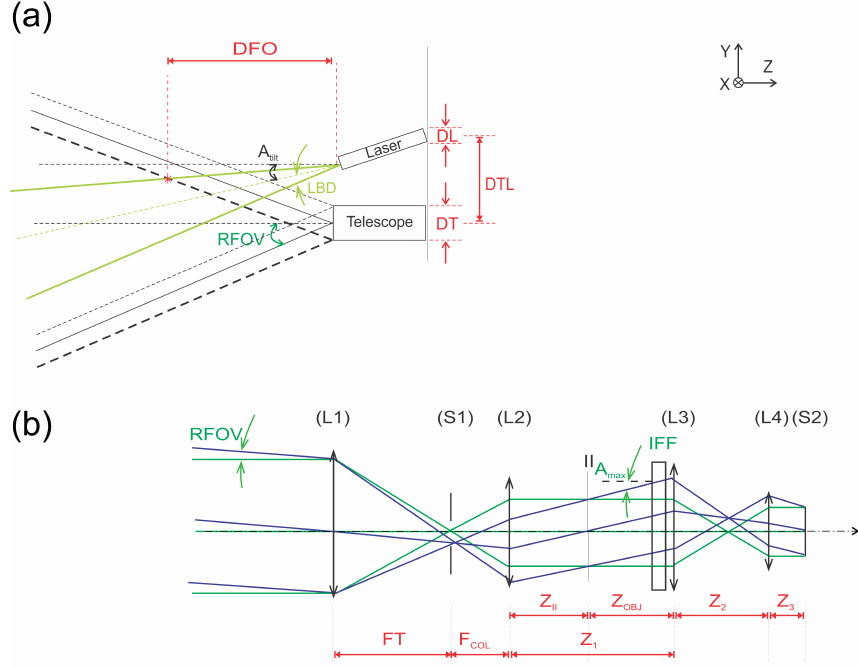
Figure 1. (a) The laser telescope geometry of a biaxial lidar system with a laser tilt A tilt and distance of full overlap DFO. RFOV and LBD are the receiver’s field of view and laser beam divergence respectively (half angles). Due to the small angle approximation, the errors are negligible when defining the laser beam diameter (DL), as if the laser was not tilted, and the distance between the laser telescope central axes (DTL) at the back of the laser and telescope. (b) The optical setup of a lidar receiving unit with a telescope (L1), field of view diaphragm LBD (S1), collimating lens (L2), interference filter and objective lens (L3) and an eyepiece lens (L4). Rays collected from on-axis (green lines) and off-axis points (blue lines) with the maximum incident angle at the telescope (RFOV), which is limited by the FOVD, reaches the IFF surface with a free aperture diameter of D obj , located at distance Z 1 from L2 under an incident angle A max . S2 is the surface of the PMT with diameter D PMT